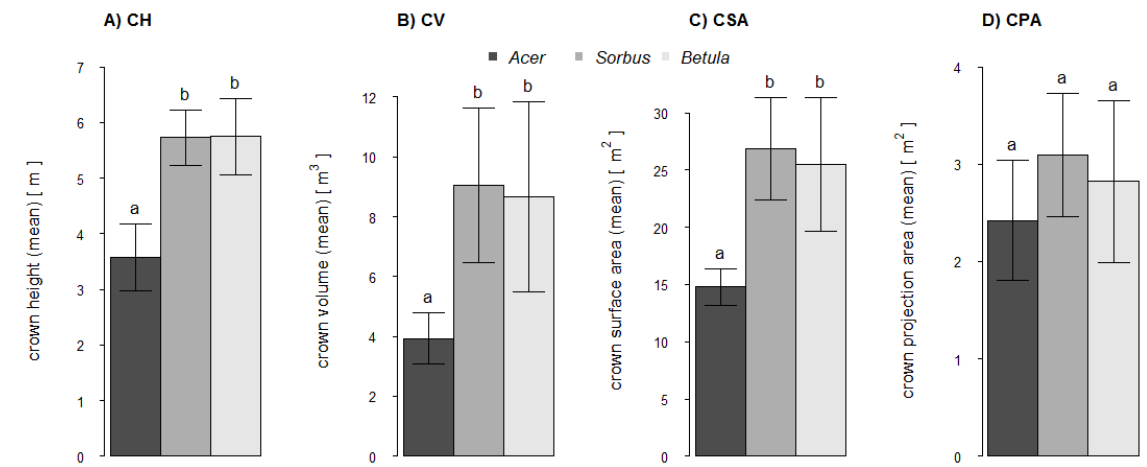
Figure 6 . Barplots of mean values (and SD) of the crown variables ( A ) crown height (CH), ( B ) crown volume (CV), ( C ) crown surface area (CSA) and ( D ) crown projection area (CPA). Different lower case letters indicate significant differences between tree species in post hoc Tukey tests ( p <